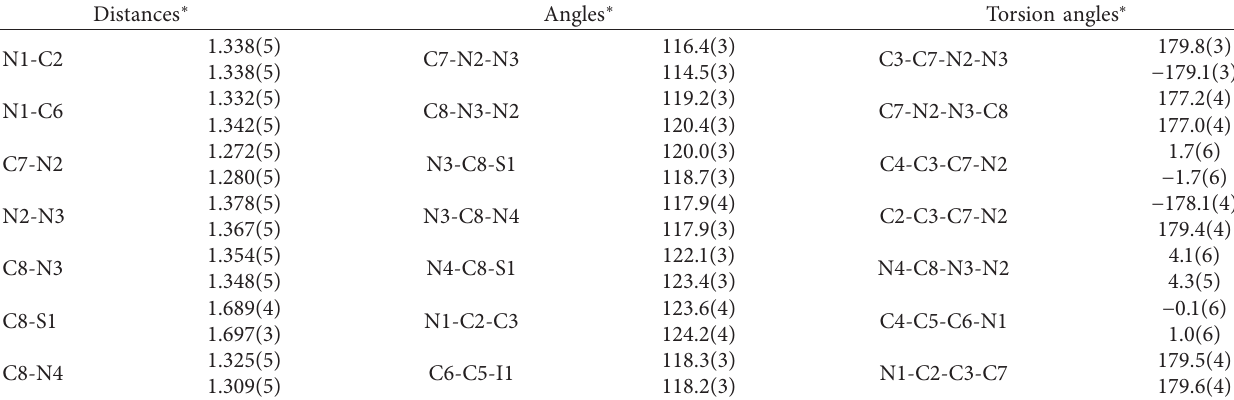
Table 2: Selected bond distances (˚A), bond angles ( ° ), and torsion angles ( ° ) of two different crystals, obtained for 7 .